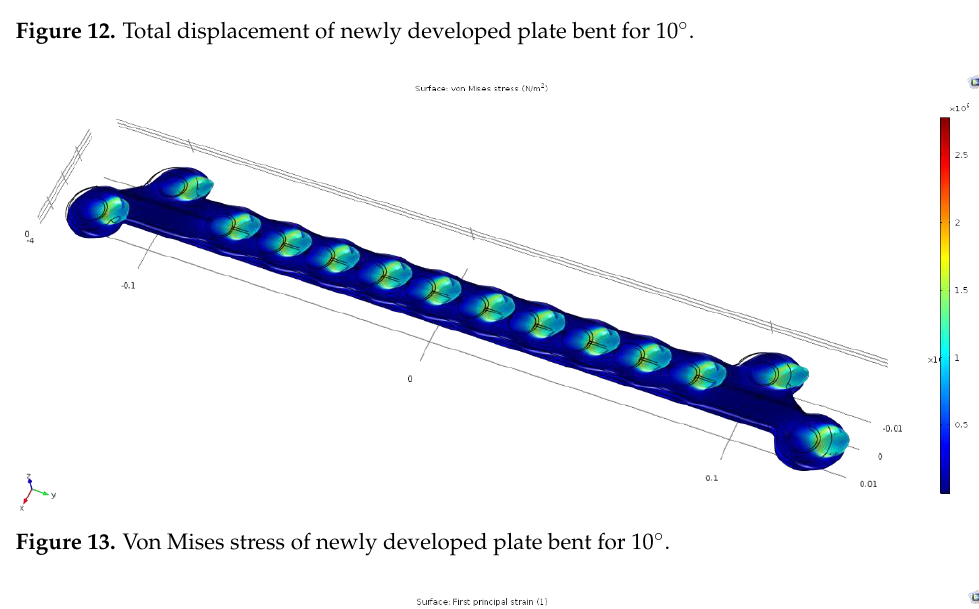
Figure 13. Von Mises stress of newly developed plate bent for 10°.